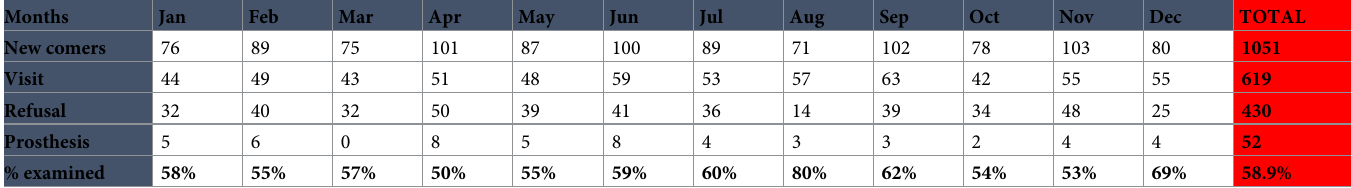
Table 3. Numbers of new inmates and oral teledentistry examinations.